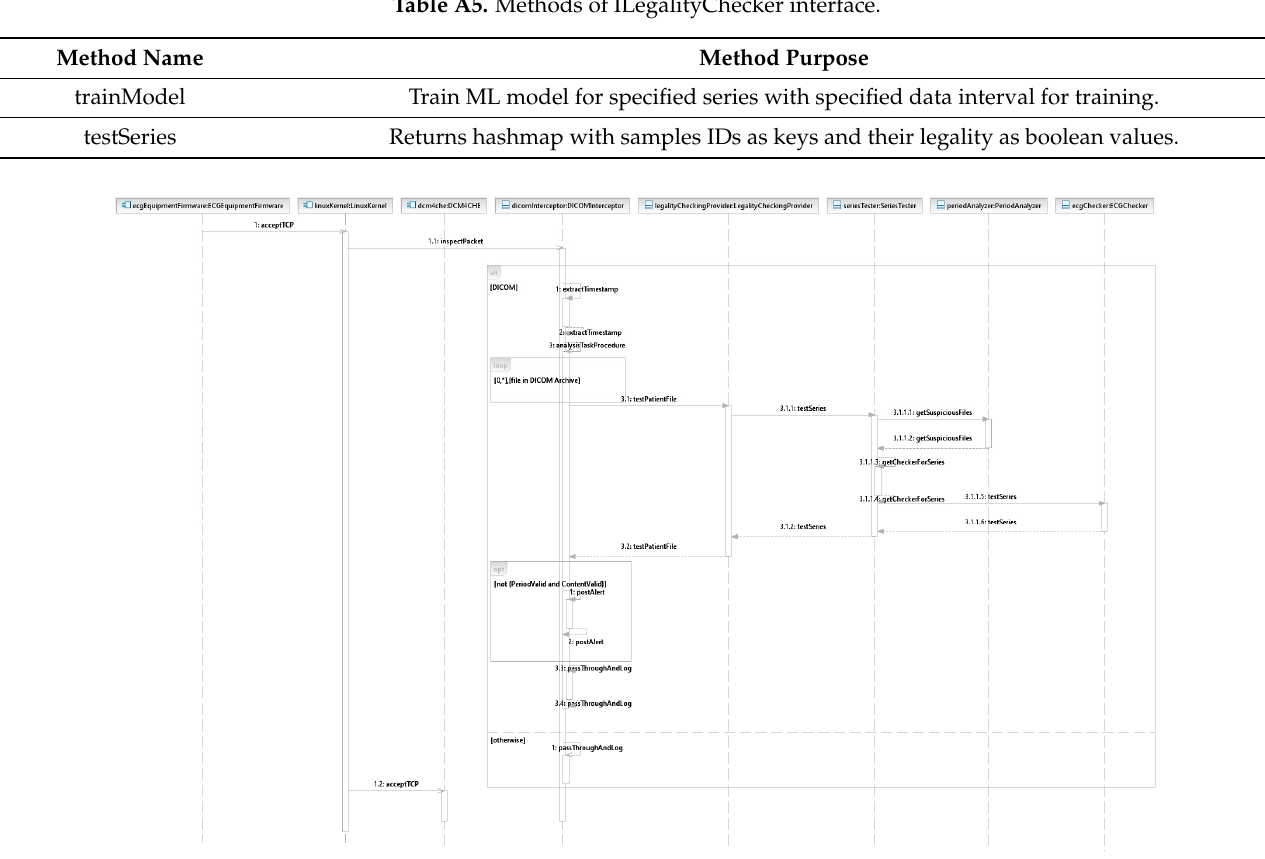
Figure A1. Analysis of incoming DICOM files (sequence